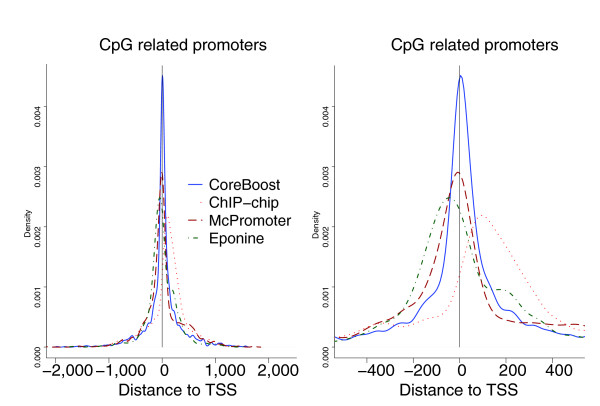
Density plot of the relative distance from the positions with maximal scores to the annotated TSS. The dot curve is based on the prediction from the ChIP-chip experiment. The solid curve is for CoreBoost. The dashed and the dot-dashed curves correspond to McPromoter and Eponine, respectively. The right figure is a zoomed in version of the left one. ChIP, chromatin immunoprecipitation; TSS, transcription start site.